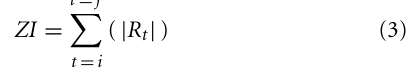
experienced long-range transport and its initial point was in the 3rd quadrant